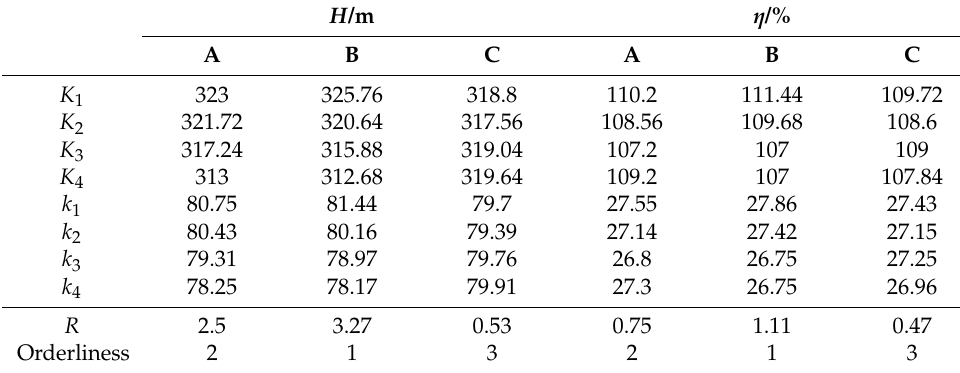
Table 8. Range analysis of the head and efficiency at 1.0 Q des .